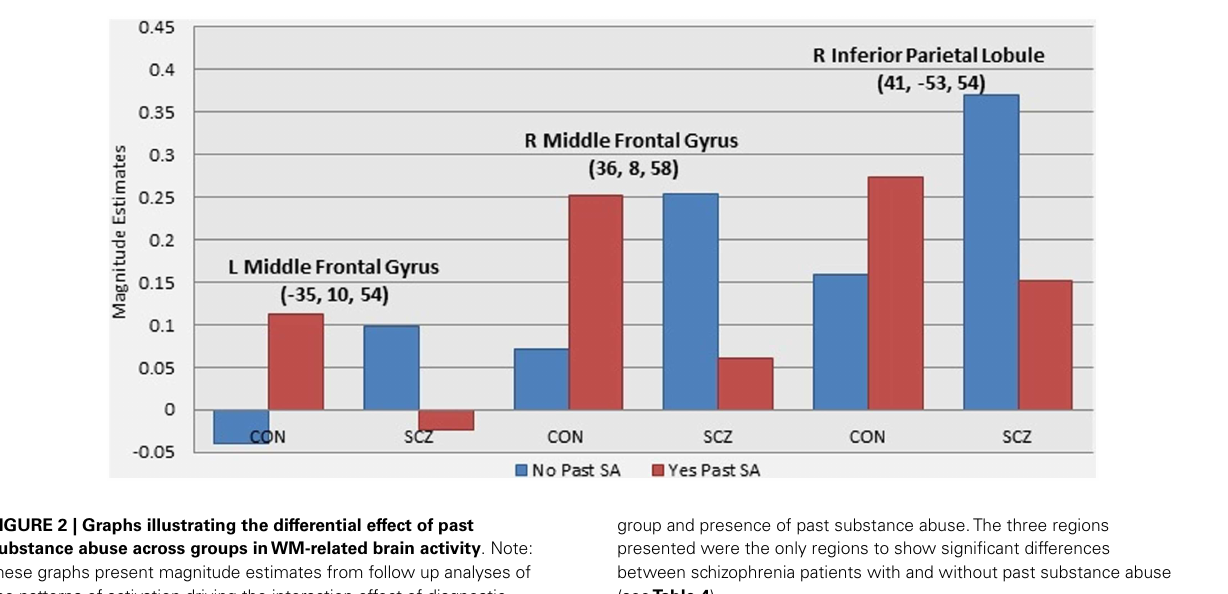
group and presence of past substance abuse.The three regions presented were the only regions to show significant differences between schizophrenia patients with and without past substance abuse (see Table 4